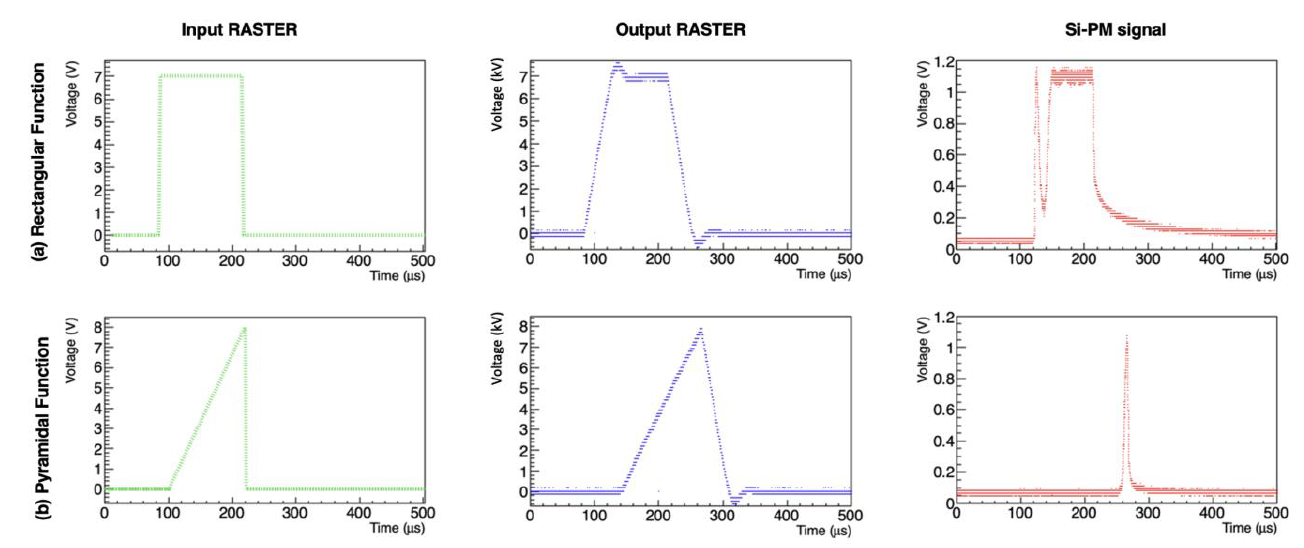
Fig. 4. Input, Output and Si-PM signal for two functions generated for pulsing the beam. First row (a) are the voltages obtained in each step for a rectangular function of 7V. The second row (b), for a pyramidal function of 8V. In green, the function generated used as input for the RASTER. In blue, the voltage induced on the RASTER’s plate. In red, the signal detected in the Si-PM outside the